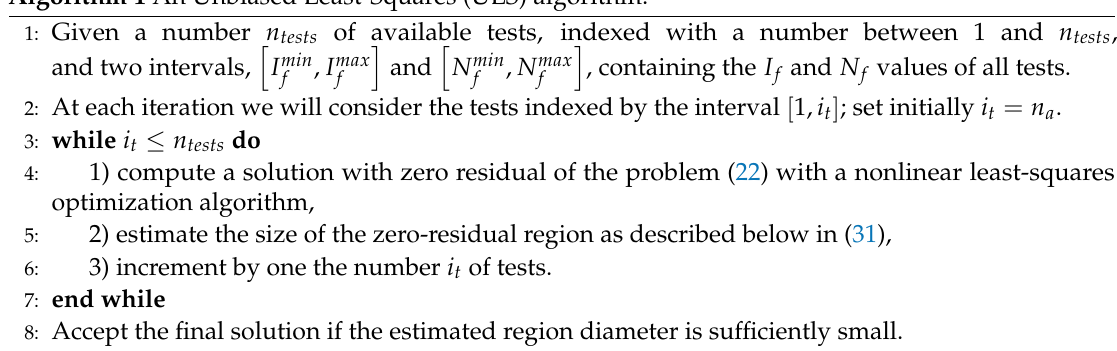
Algorithm 1 An Unbiased Least-Squares (ULS)